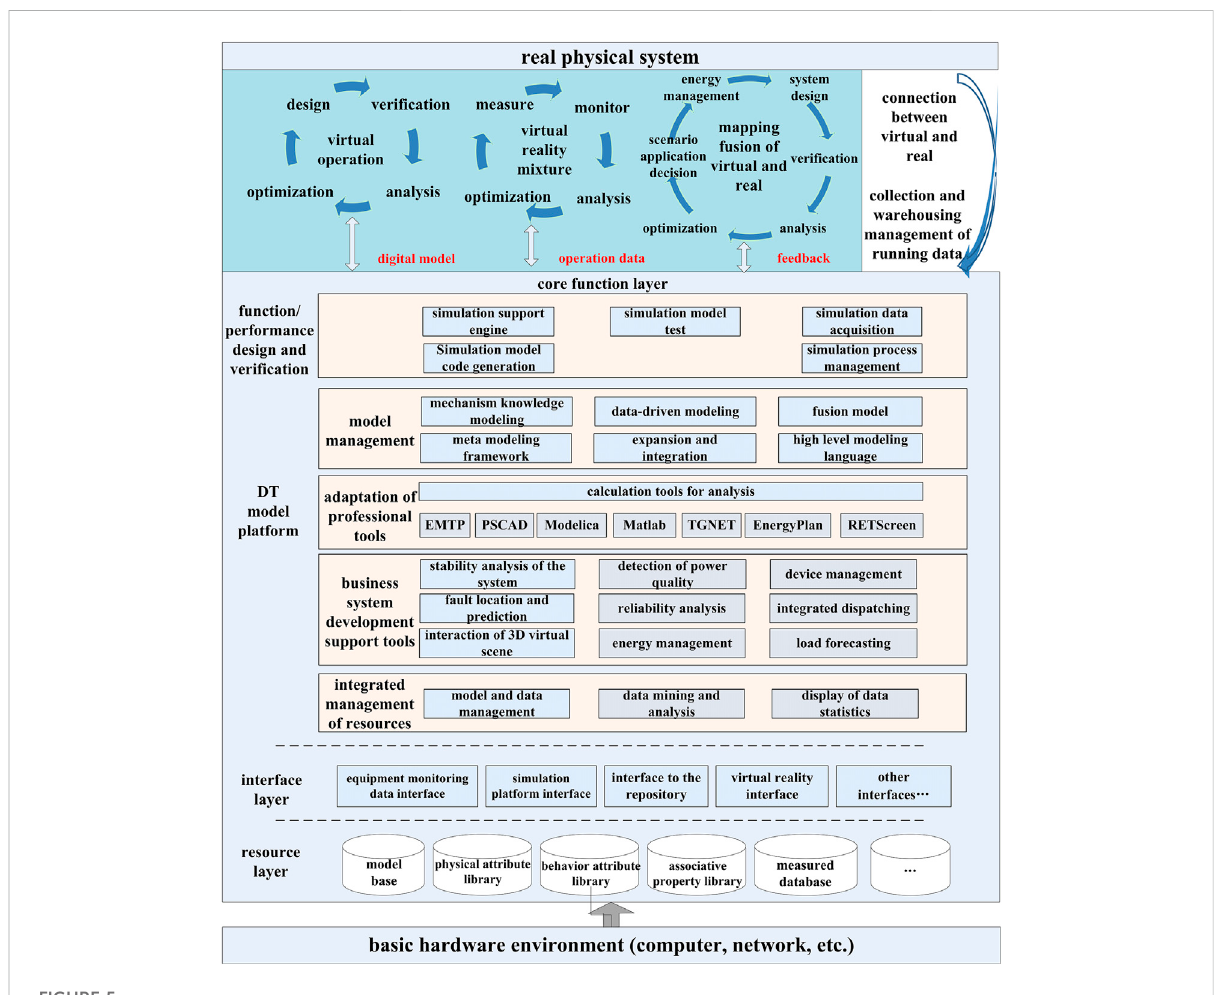
FIGURE 5 Digital twin model platform architecture for